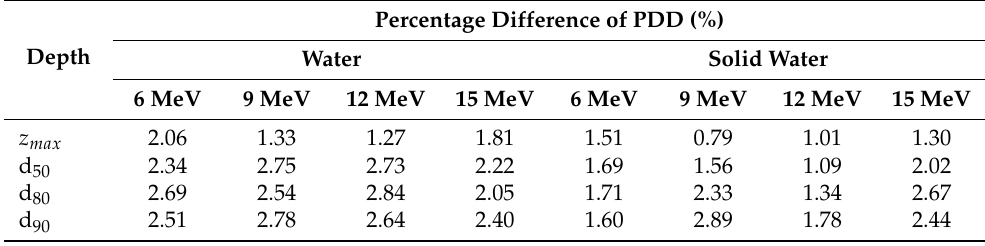
Table 11. Comparison of PDD curves between DSF/NaOH/IA-PAE/ R. spp., water and solid water phantoms for different electron